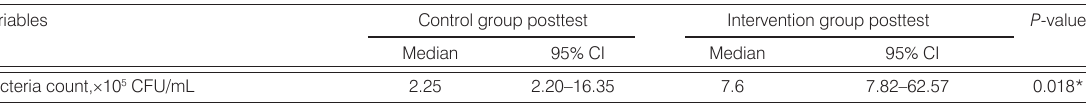
Table 3. Pretest and posttest independent bacteria